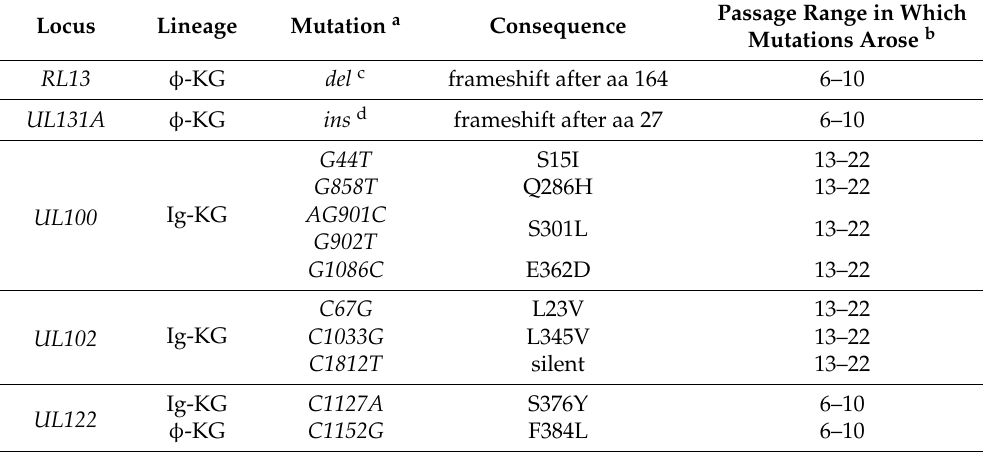
Table 1. Emergence of mutations during serial